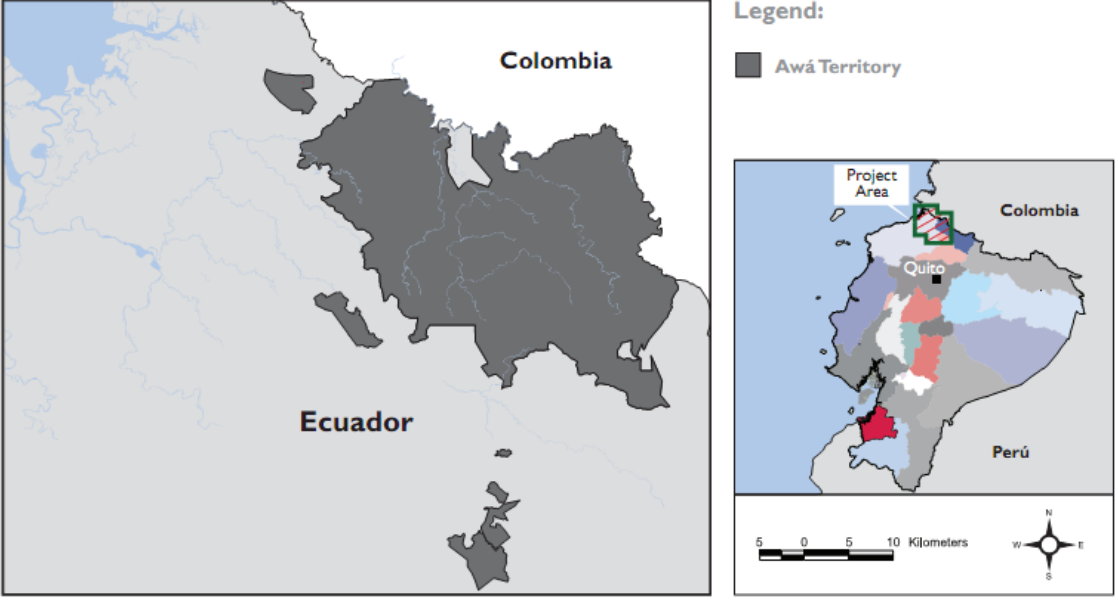
Figure 3. Territory managed by the Awa Indian nation within Ecuador. Adapted from